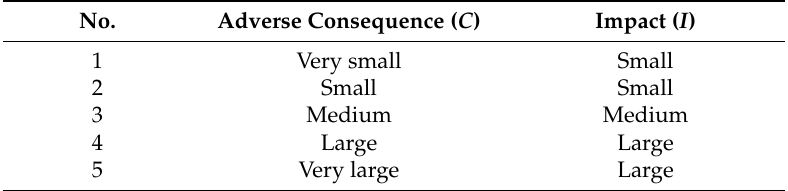
Table 6. Relationships between adverse consequence ( C ) and impact ( I ).